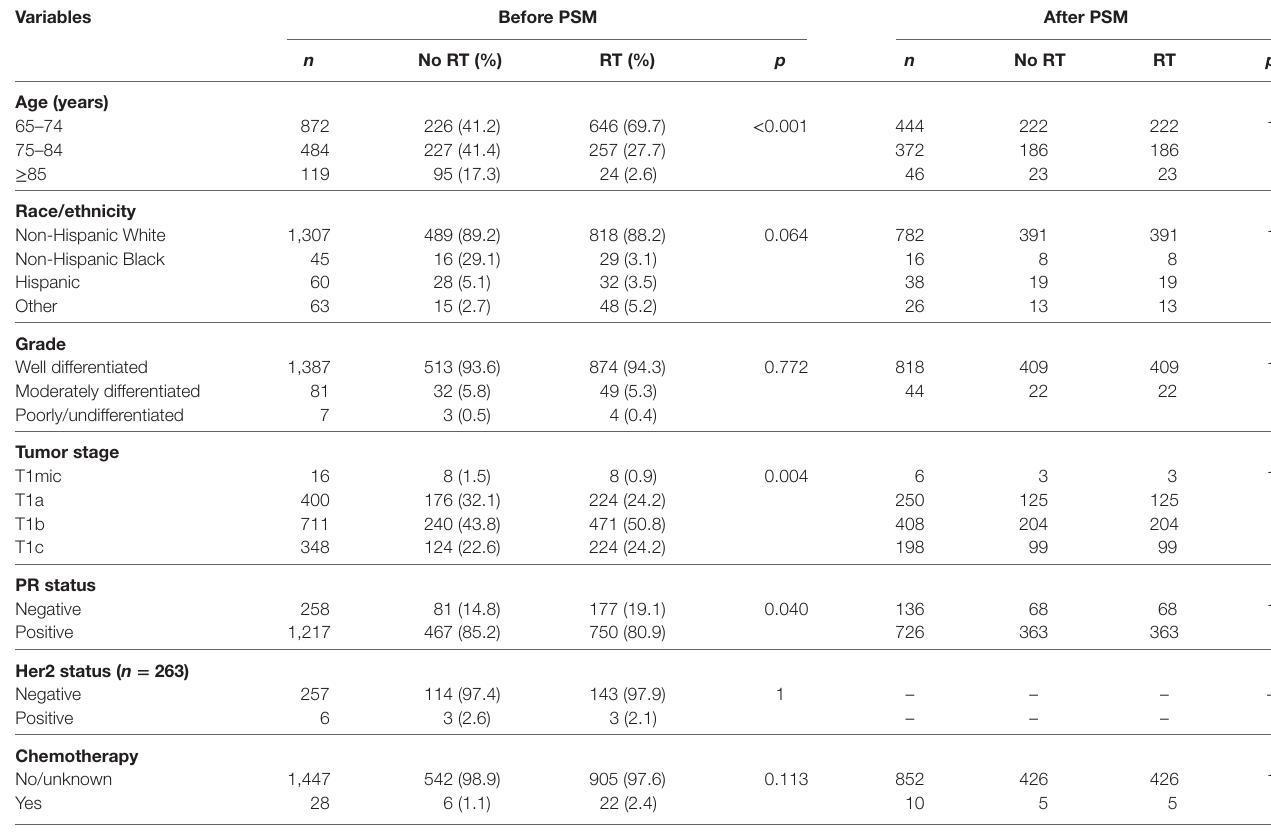
TaBle 1 | Patient characteristics before and after propensity score matching.